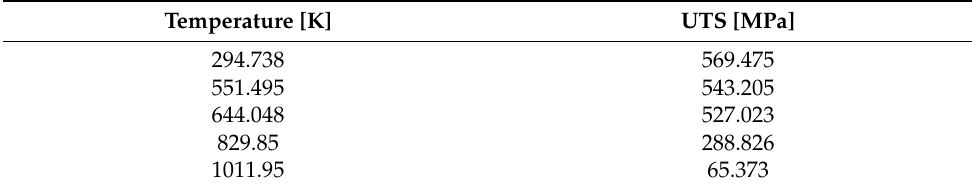
Table 2. UTS as a function of temperature (Reproduced from [22], Elsevier: